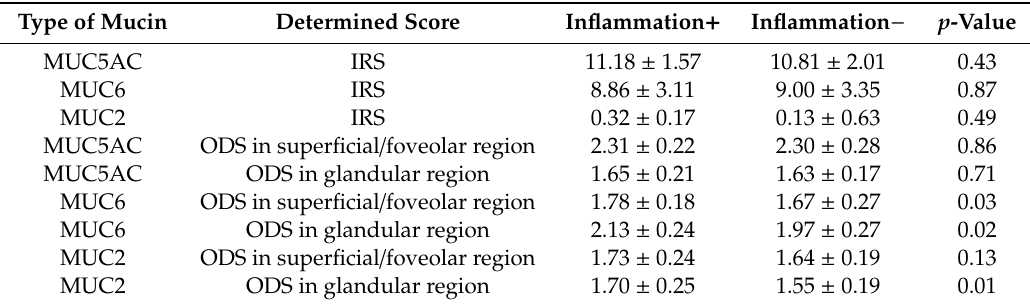
Table 2. Comparison of mucin expression in the antral mucosa between cases presenting chronic inflammation and cases without inflammation.